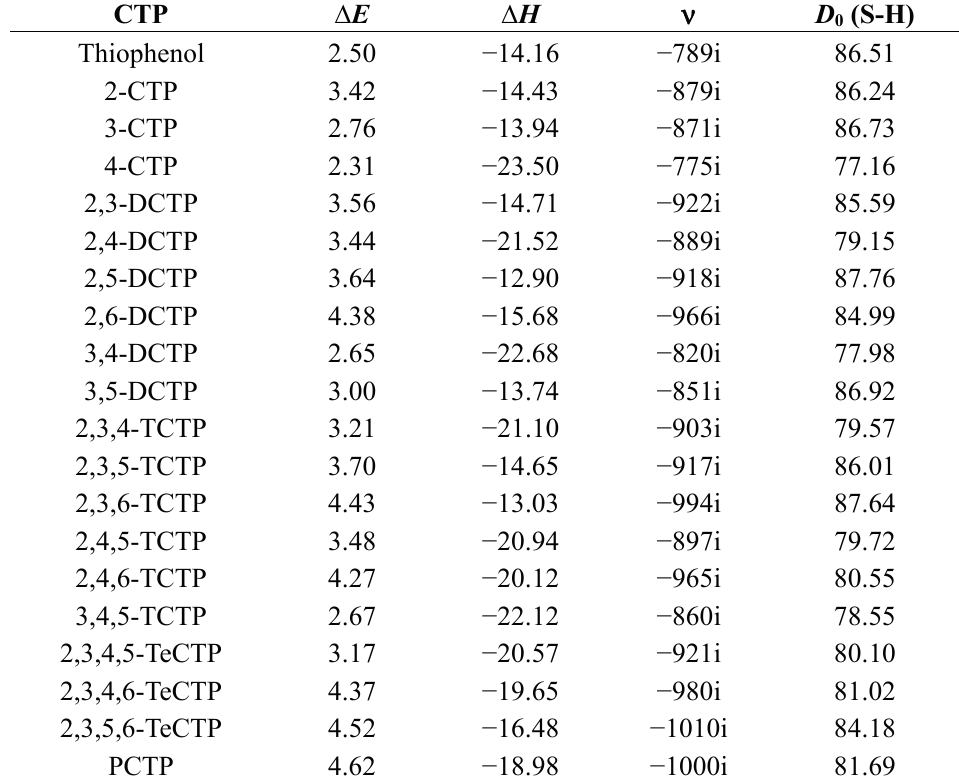
Table 1. Potential barriers ∆ E (in kcal/mol), reaction heats ∆ H (in kcal/mol, 0 K), imaginary frequencies (in cm − 1 ) of the transition states, and the S–H bond dissociation energies D 0 (S–H) (in kcal/mol) for the thiophenoxyl-hydrogen abstraction from CTPs by H.